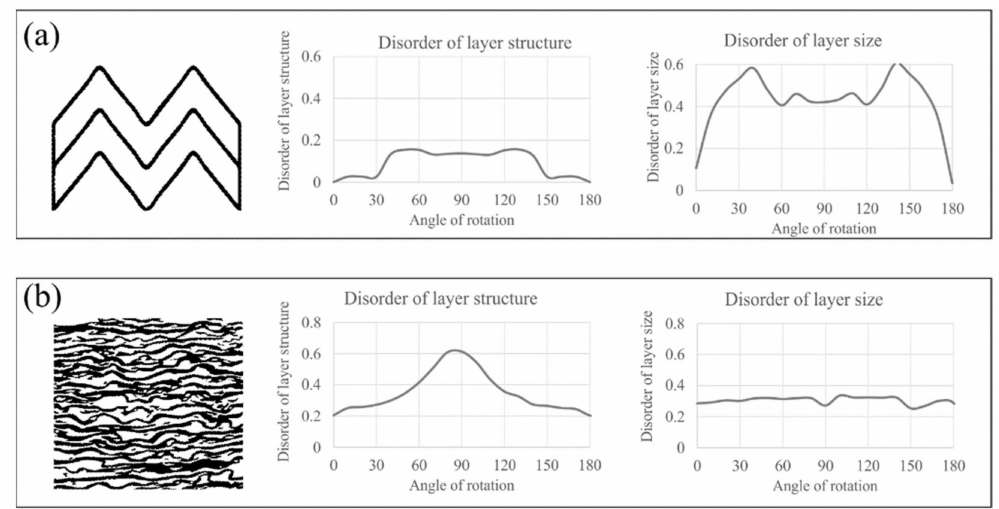
Figure 9. Morphology of multi-oriented patterns. ( a ) Morphology of a simple geometrical shape as a function of the pattern rotation. ( b ) Morphology of a complicated human aorta shape as a function of the pattern rotation. Credit. Human aorta [33]; Hans Snyder/JMD Histology & Histologic Inc.,